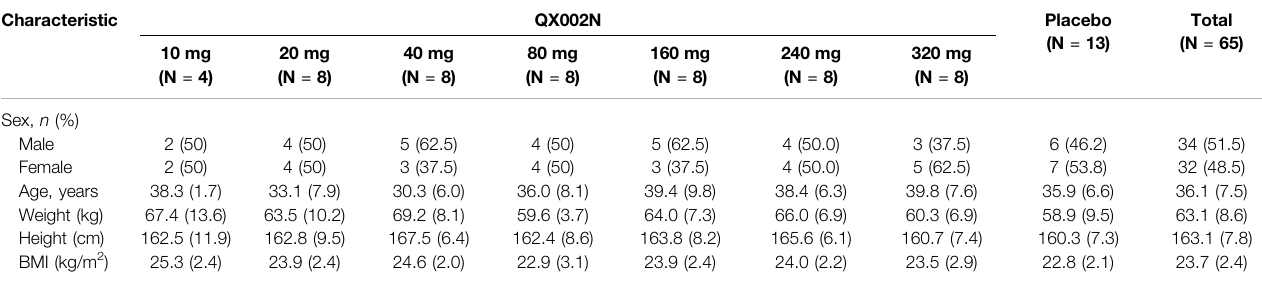
TABLE 1 | Summary of the demographic characteristics.